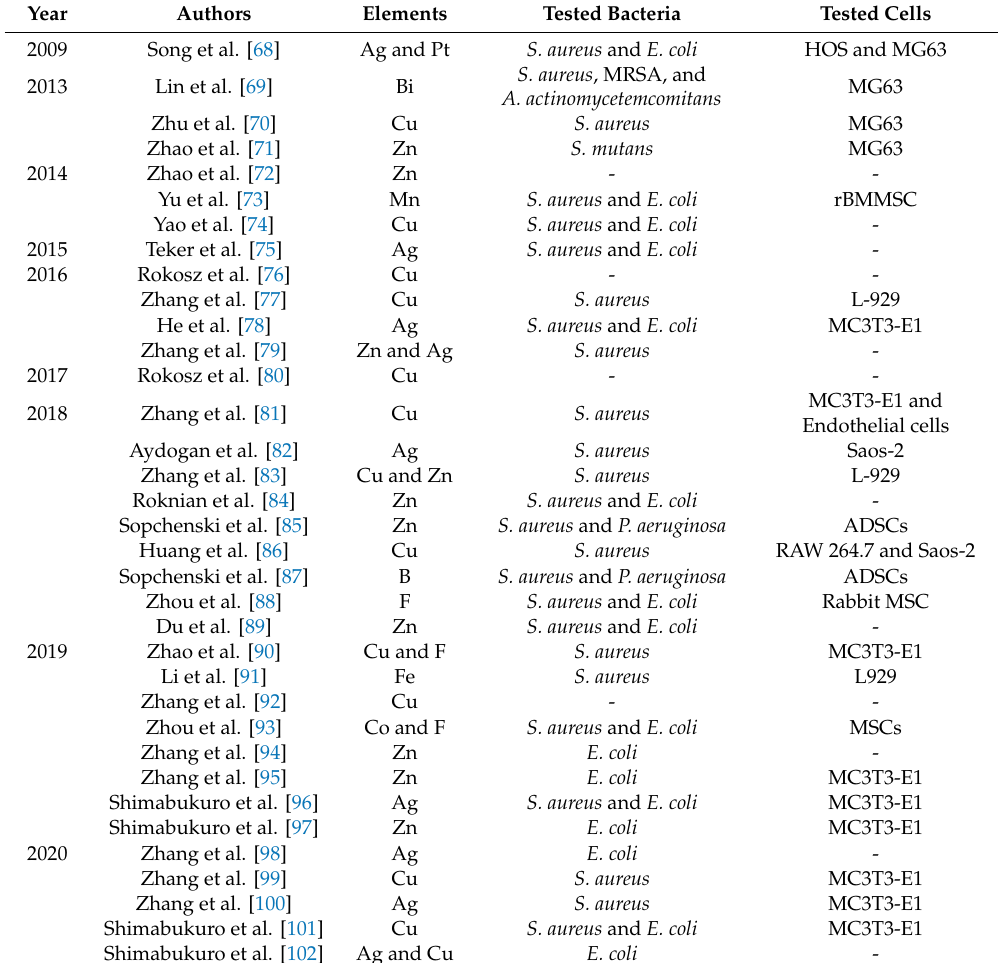
Table 2. Summary of the published articles related to the incorporation of antibacterial elements onto the Ti surface by one-step